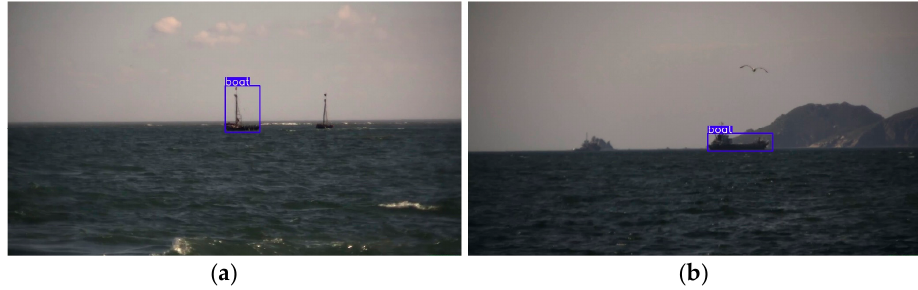
Figure 16. Extraction results for the multi-ship case: ( a ) Test results in a simple background; ( b ) Test results in a complex background.